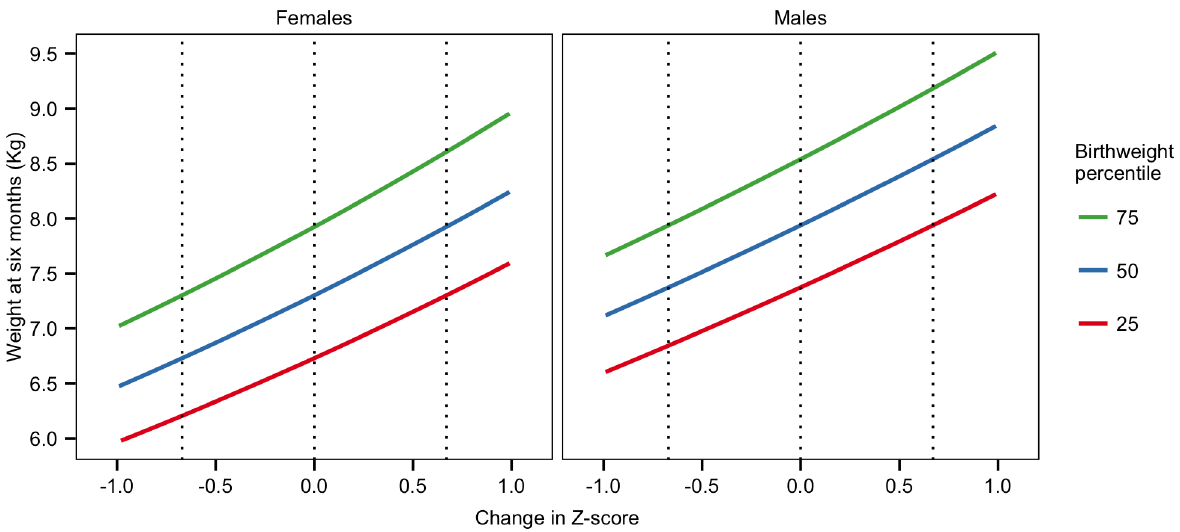
Figure 1. Theoretical description of the relationship between weight at six months and change in Z-score, as defined by the WHO growth curves. The relationship is displayed for multiple birthweight percentiles. A change in Z-score of 0 corresponds to theoretically perfect growth at six months. If a male child was born at the 75th percentile, then their expected weight at six months would be 8.5 kg (y-axis), corresponding to 0 change in Z-score (x-axis) on the right panel. If the child instead weighed 9.0 kg at six months (y-axis), then that would correspond to a z 0 : 5 change in Z-score (x-axis).